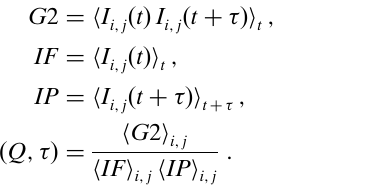
Fig. S1 of the supporting information), IP and IF are invariant